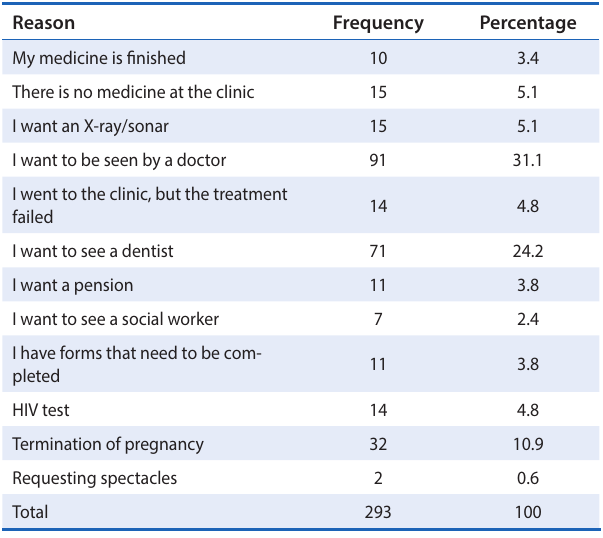
Table 2. Reasons for coming to the hospital